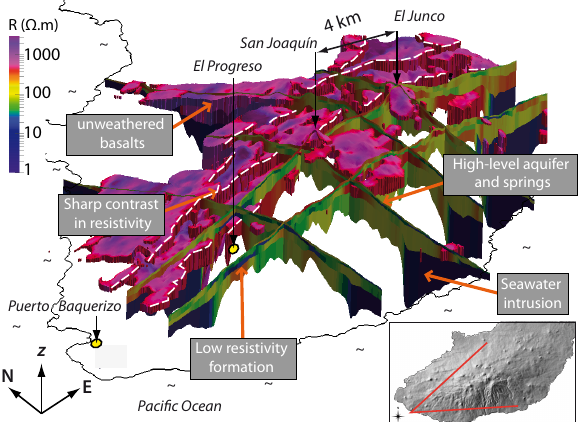
Fig. 6. Depth to the saltwater interface (SWI) inferred from the 4 layer resistivity model. SWI elevation is estimated from the eleva- tion of the upper interface of the deep, very conductive geophysical layers ( < 15 (cid:127) m). Values a.s.l. are artefacts and should be disre-